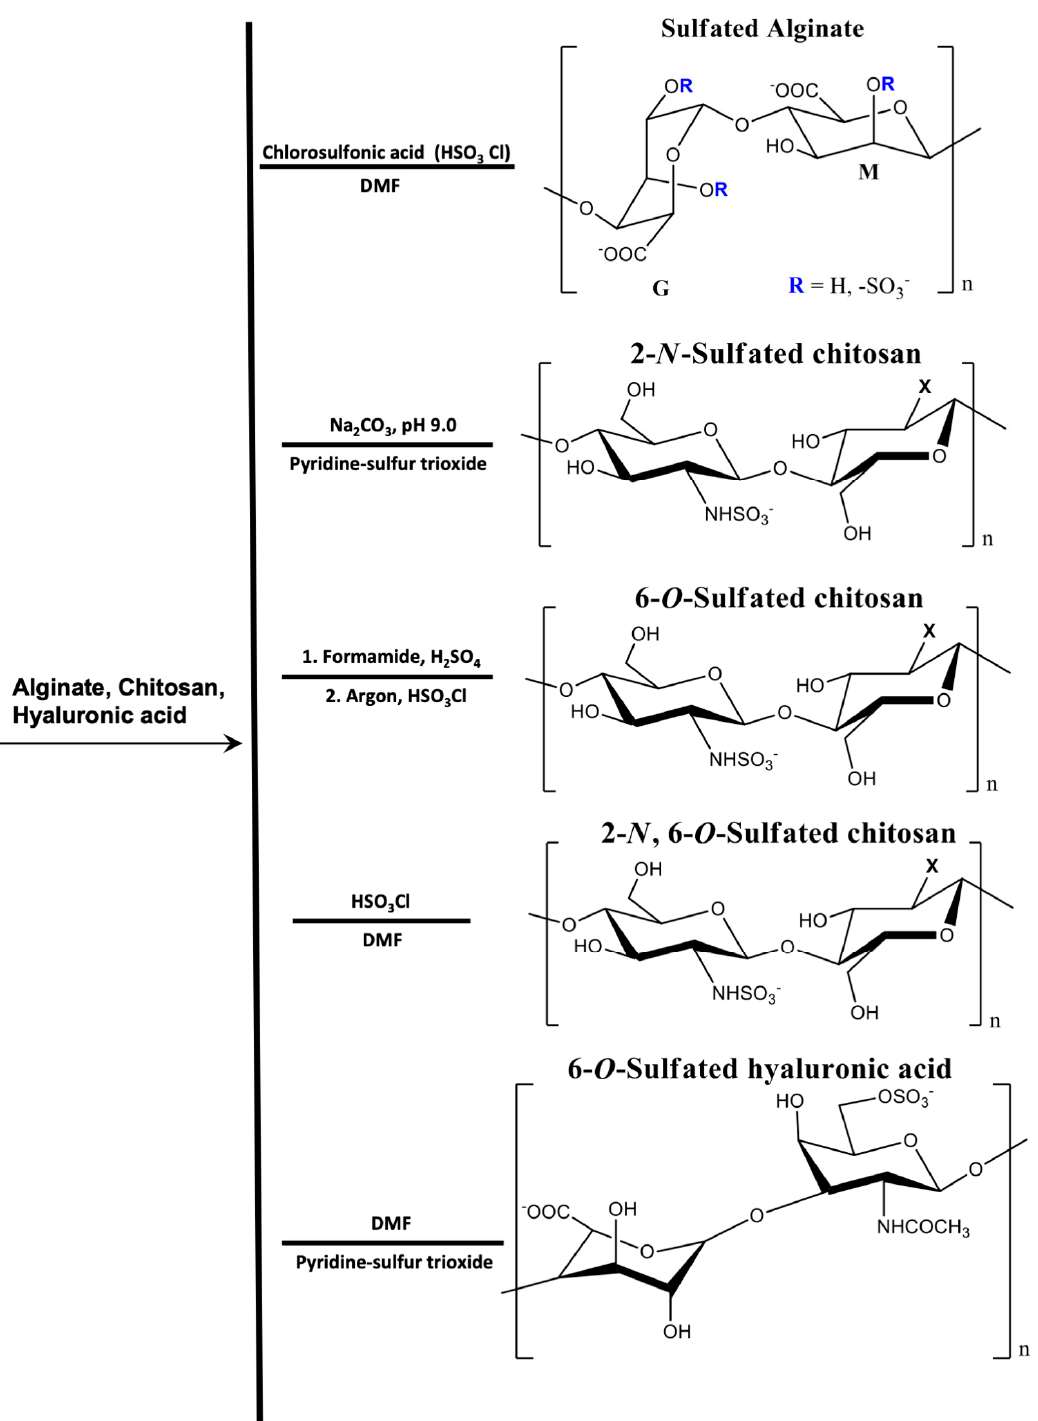
Figure 7. Chemical structures of artificially sulfated polysaccharides obtained from alginate, chitosan, and hyaluronic acid.